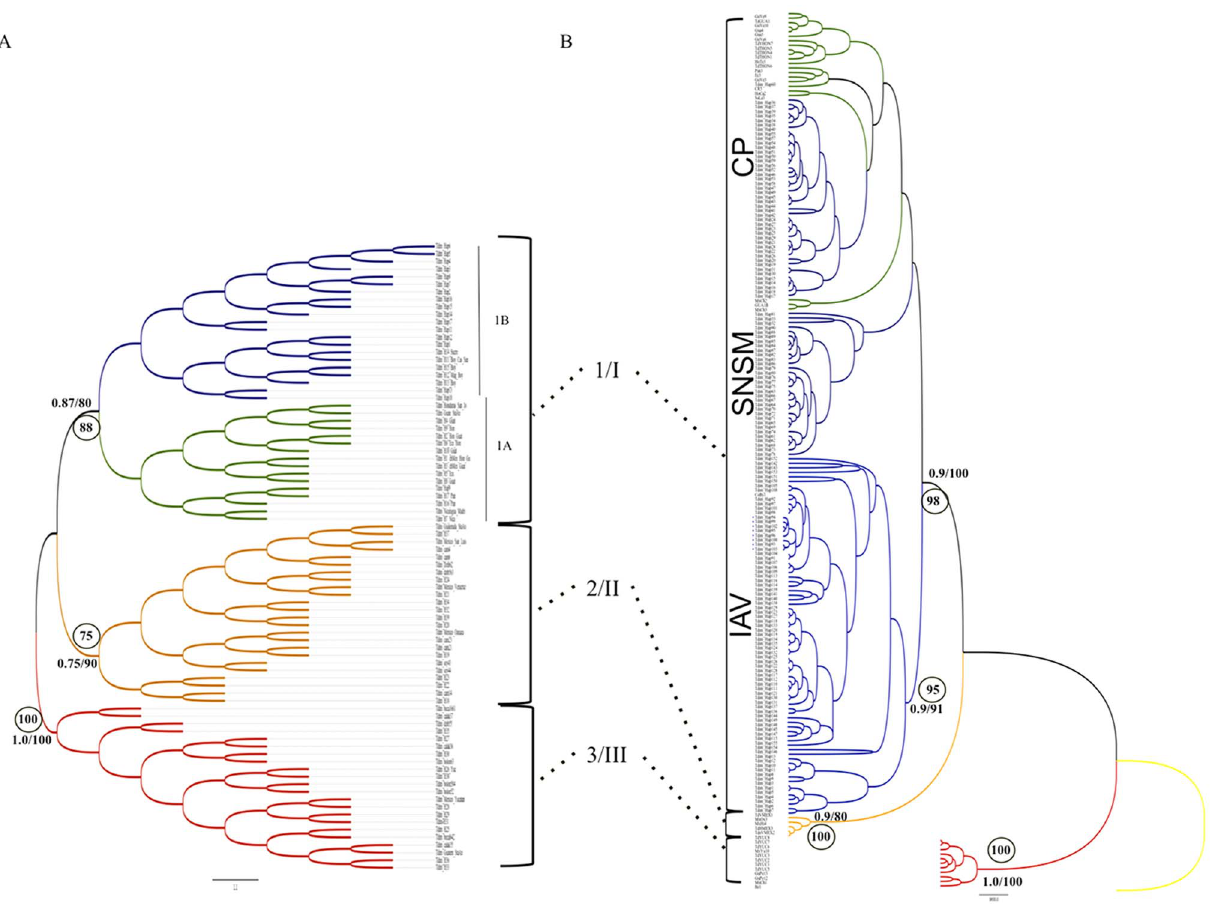
Figure 7. Phylogenetic analyses of T.dimidiata based on A) partial ITS-2 fragment and B) the ND4 gene. Numbers on nodes indicate posterior probability and bootstrap values (only posterior probabilities . 0.75 and Bootstrap values . 75% are shown); circled numbers indicate match node scores between BI and ML-based topologies. In B) the names of the three eco-geographical regions described for Colombian T. dimidiata are indicated. Branch color codes and dotted lines indicate each of the main different genetic groups that comprise the T. dimidiata species complex according to Bargues et al. , (2008) and Monteiro et al. , (2013).